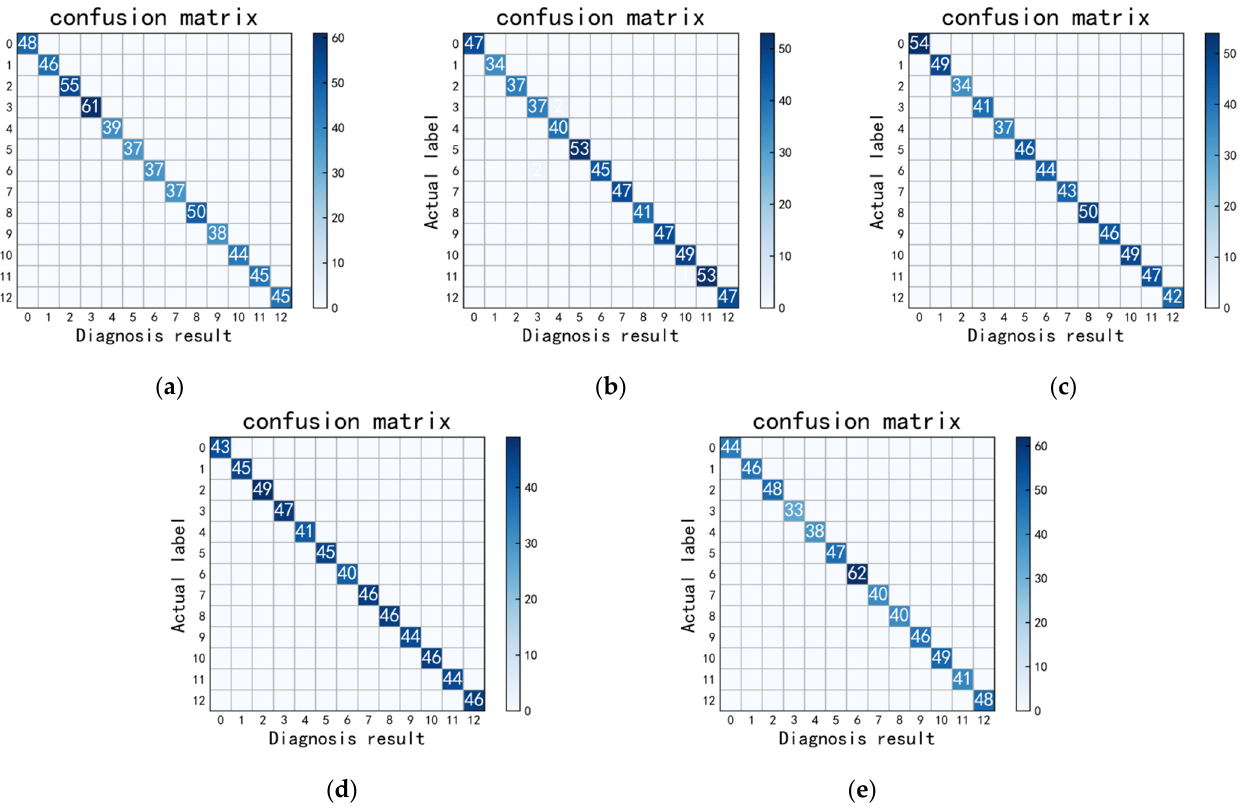
Figure 9. Five rounds of random experiments with thirteen faults(a-e: First to fifth rounds of random experiments).